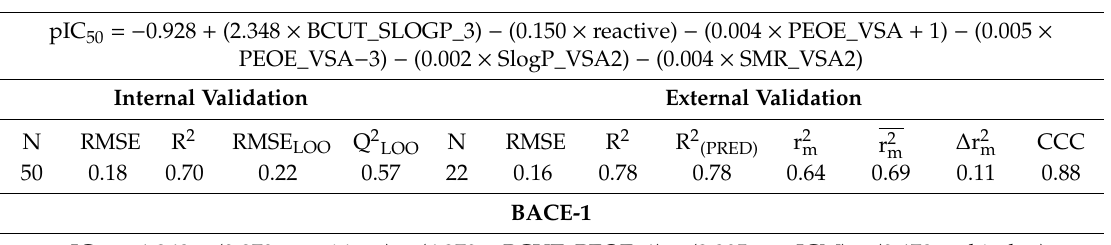
Table 3. 2D-QSAR models for AChE and BACE-1 inhibitors. AChE